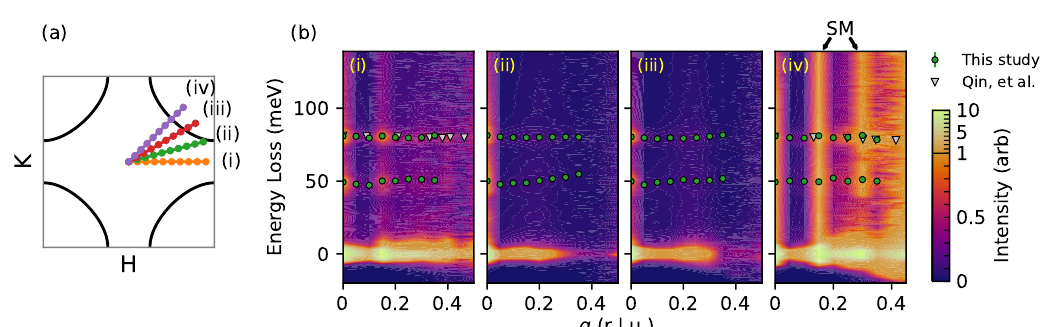
Figure 5: (a) Brillouin zone of Bi2212 indicating the four momentum space trajectories used for M-EELS studies, labeled (i)-(iv). (b) Momentum-dependent M-EELS spectra of optimally- doped Bi2212 at 20 K for the four momentum directions indicated in panel (a). A custom color scale was devised so that strong features around the zero-loss line can be observed on the same figure as weak phonon features (see scale bar). The bright, vertical lines labeled “SM” are a ( q − G ) , which is enhanced when q coincides consequence of the Coulomb matrix element, V 2 eff with a structural periodicity in the material, in this case the structural supermodulation. The dispersions of the optical phonons (green points) are consistent with previous studies (empty triangles) reproduced from Ref. [ 53 ]